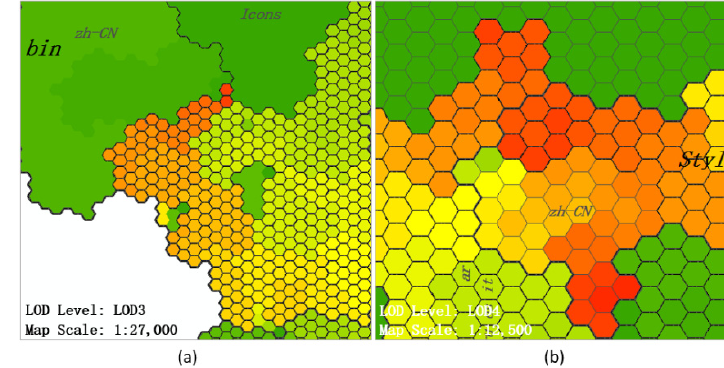
Figure 16. Two large file communities that are divided into the smallest unit: ( a ) for LOD3; ( b ) for LOD4.